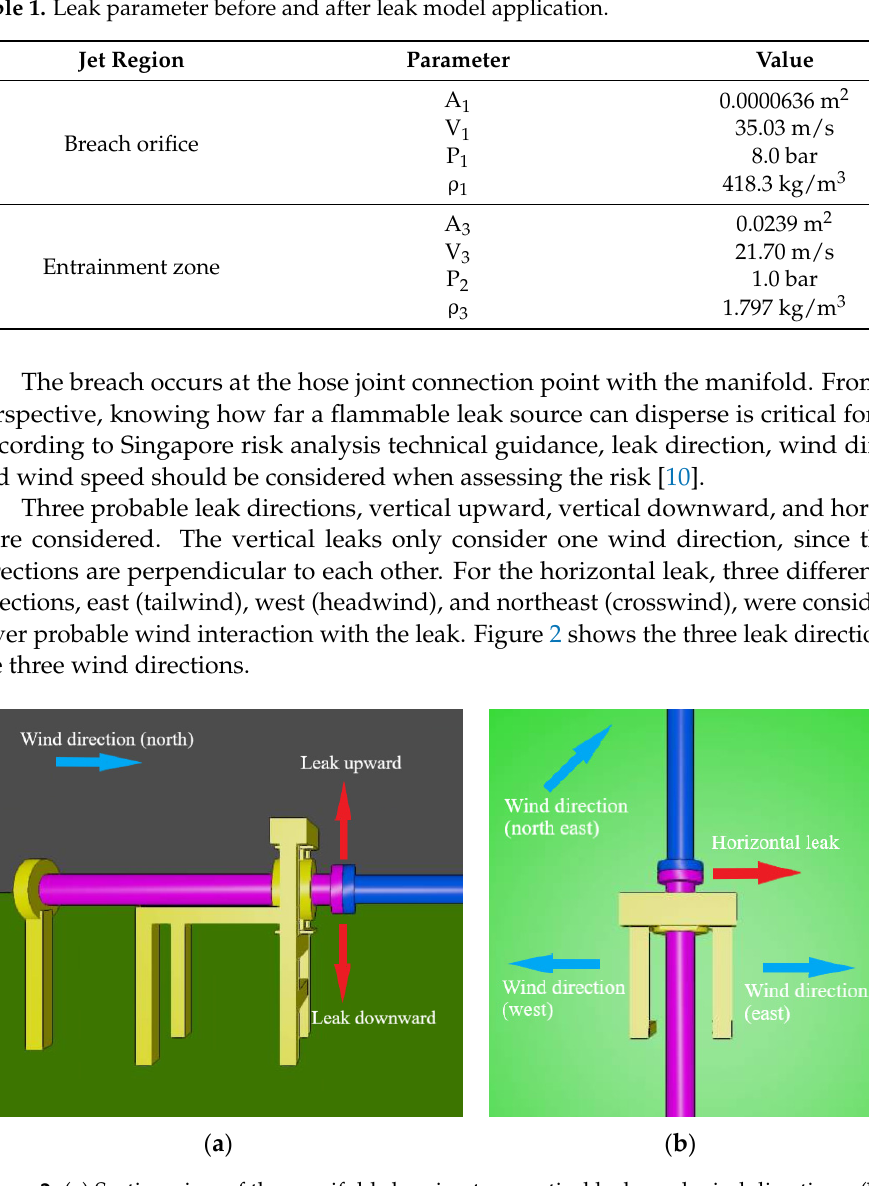
Table 1. Leak parameter before and after leak model application.